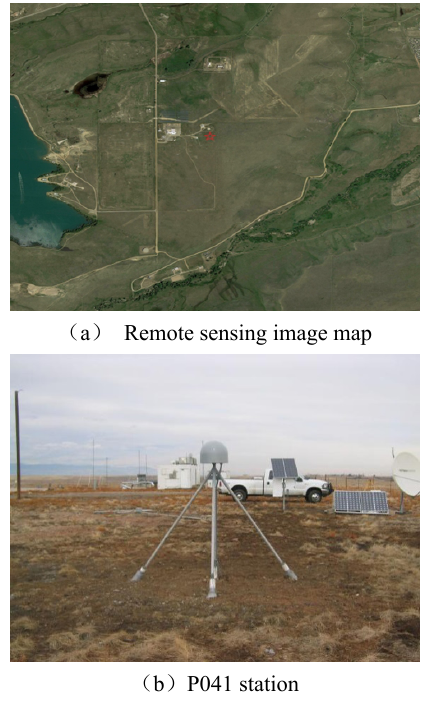
Fig.3 P041 station surrounding